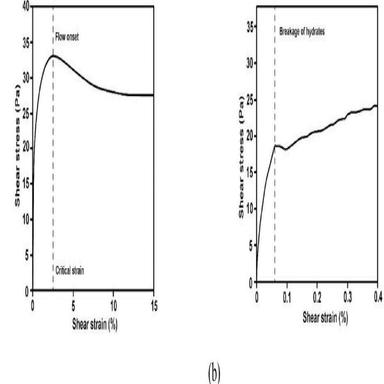
CSR test of cement paste (W/C = 0.4)-the relationship between shear strain and shear stress. (a) Shear strain from 0% to 15%; (b) Shear strain from 0% to 0.4%. Adapted from.